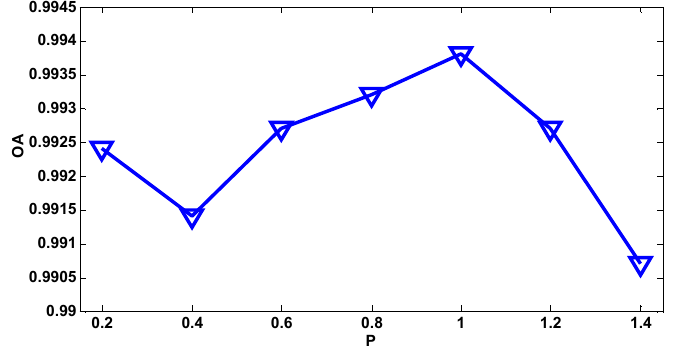
Figure 9. OA values vs different ratio P between the number of virtual and original samples.